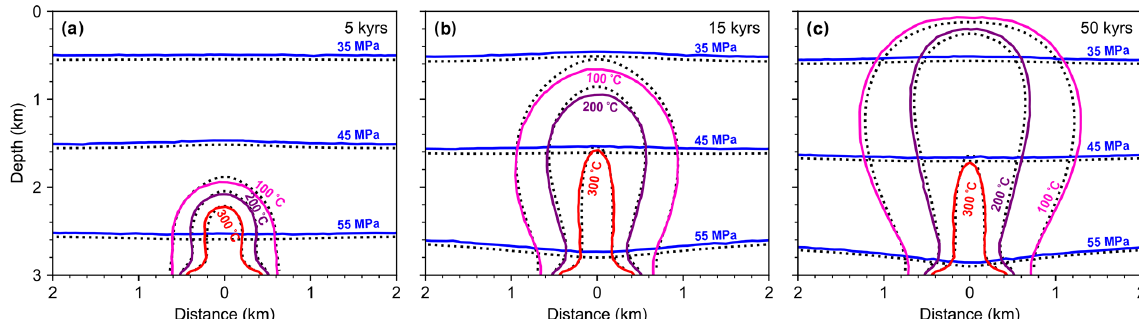
Figure 7. Snapshots of two-dimensional examples. Contour lines for fluid pressure (blue) and temperature (red) calculated from Hydrother- malFoam are plotted as solid lines and those from HYDROTHERM are plotted as dotted lines (black). The visualization window is shown by the black box in Fig.